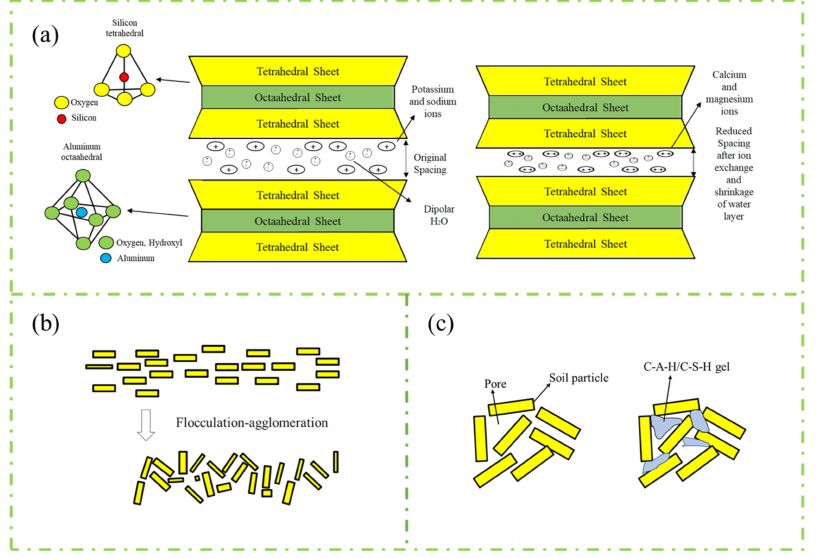
Figure 3. Stabilization mechanism: ( a ) cation exchange; ( b ) flocculation-agglomeration; ( c ) pozzolanic reaction. Adapted from